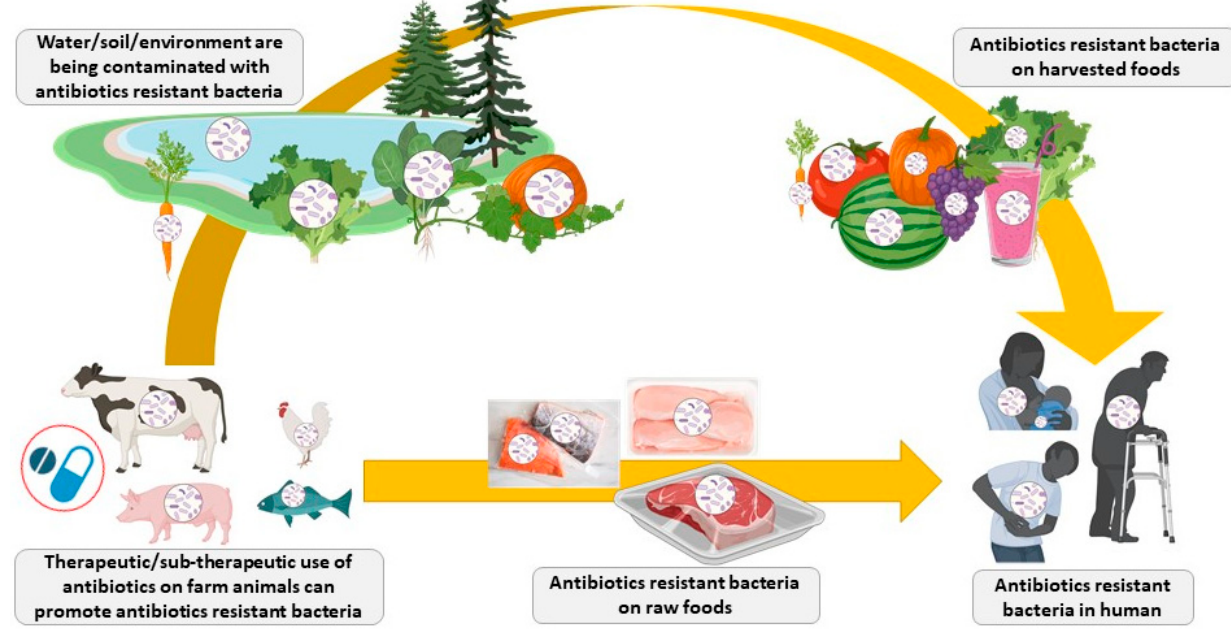
Figure 1. Spread of antibiotic-resistant bacteria from livestock animals to humans (Figure created in biorender, https://biorender.com/).